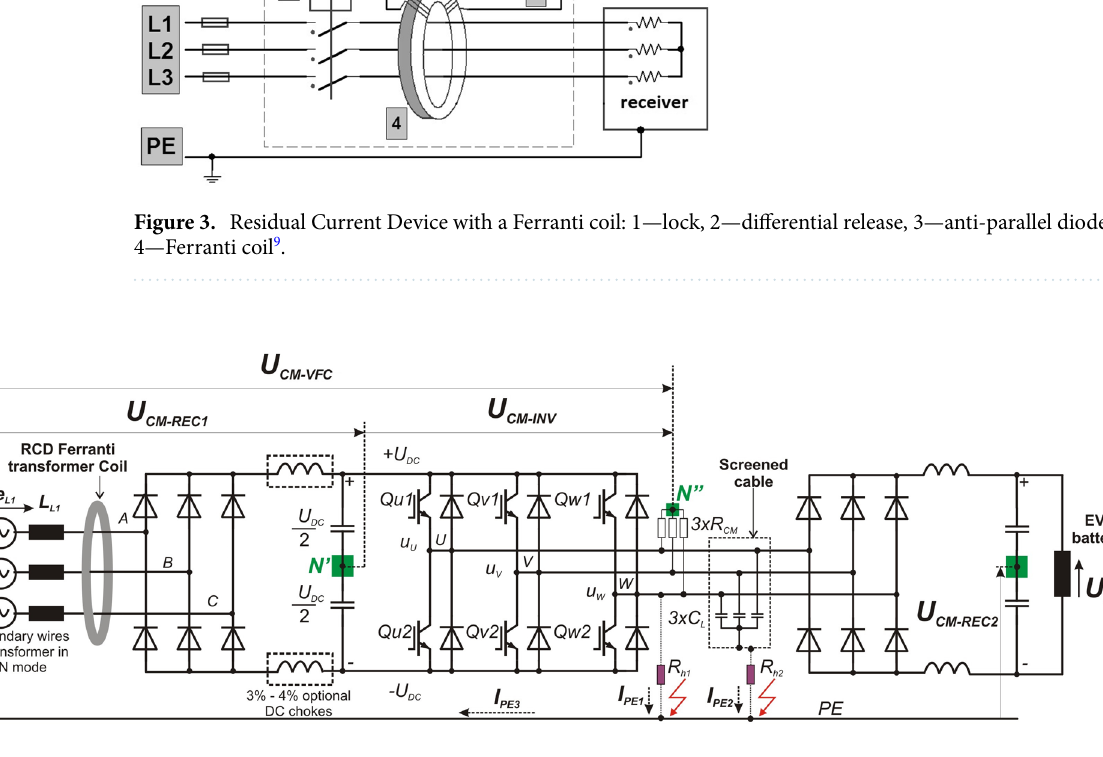
Figure 4. The model of the EV charging system with the VFC and the residual current device for protection against ground